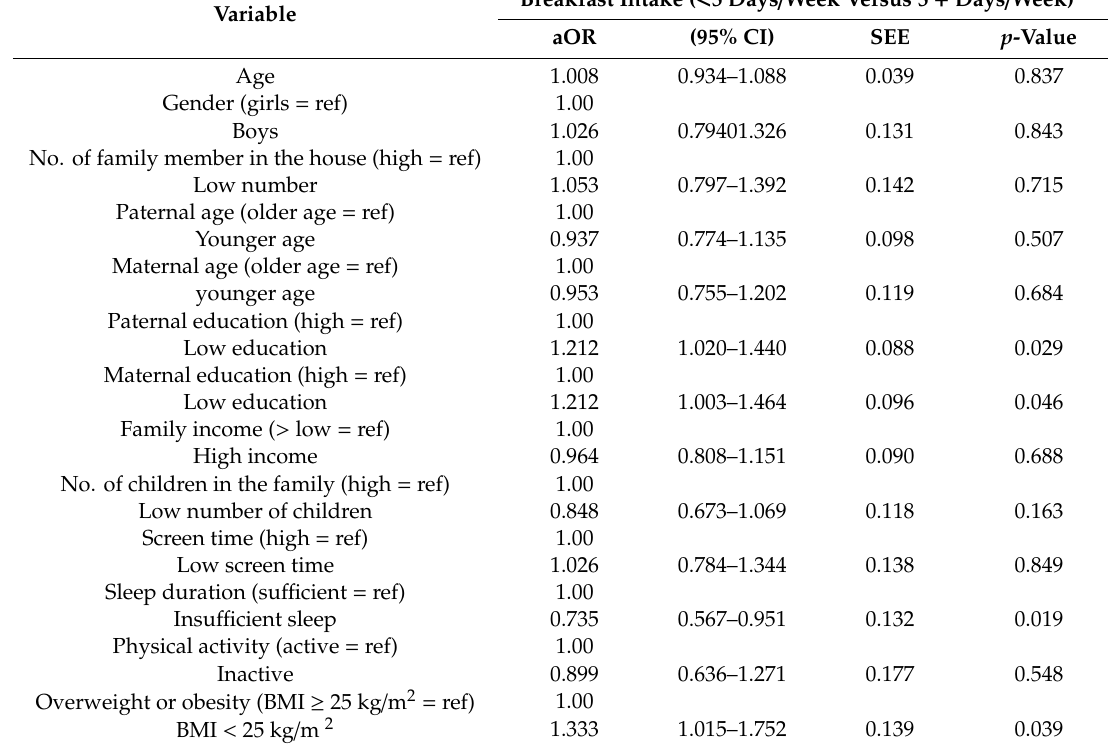
Table 8. Results of logistic regression analysis of selected lifestyle behaviors and overweight / obesity status relative to high versus low breakfast intake frequency among Saudi children, while adjusted for age, gender, and socio-demographic factors ( N =